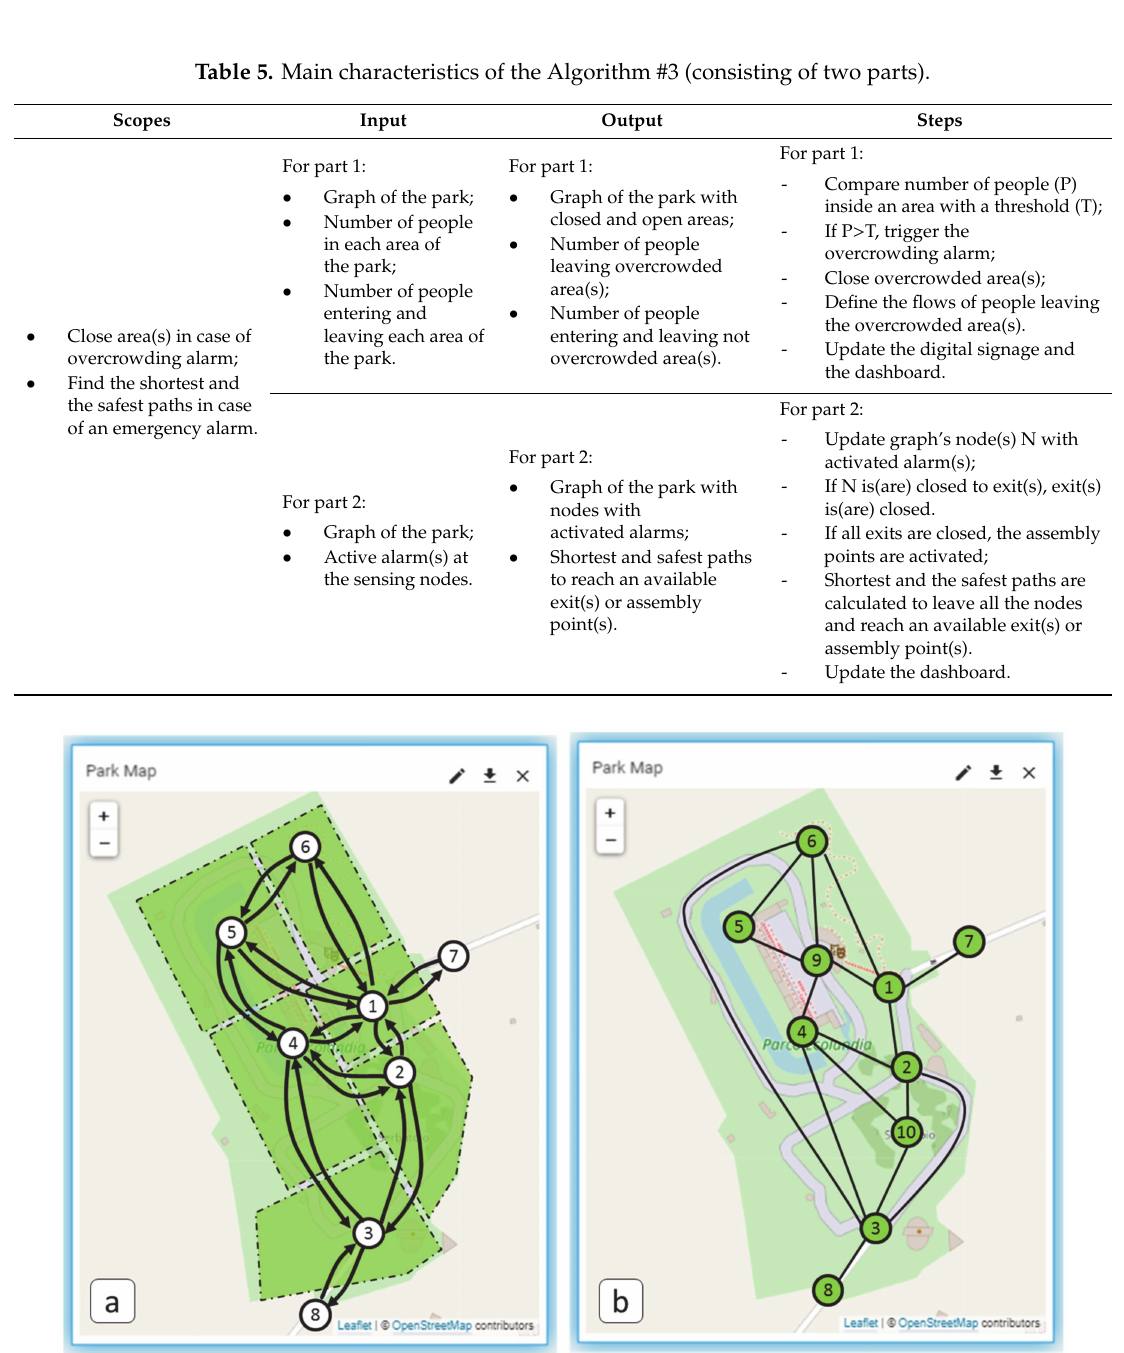
Figure 4. Graphs used by the Algorithm 3 in case of ( a ) Overcrowding alarm (Case study 1: monitoring scenario and social distancing); ( b ) Environmental and / or Structural alarm (Case study 2: emergency scenario and emergency